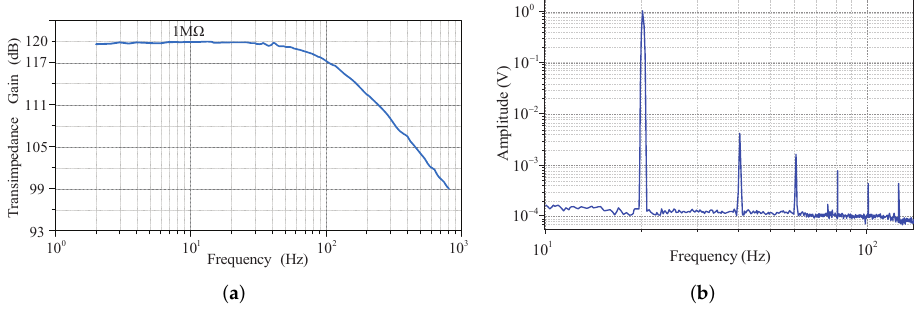
Figure 11. ( a ) Frequency response of the RX. ( b ) Measured output spectrum of the TIA with the transimpedance gain of 1 M Ω .